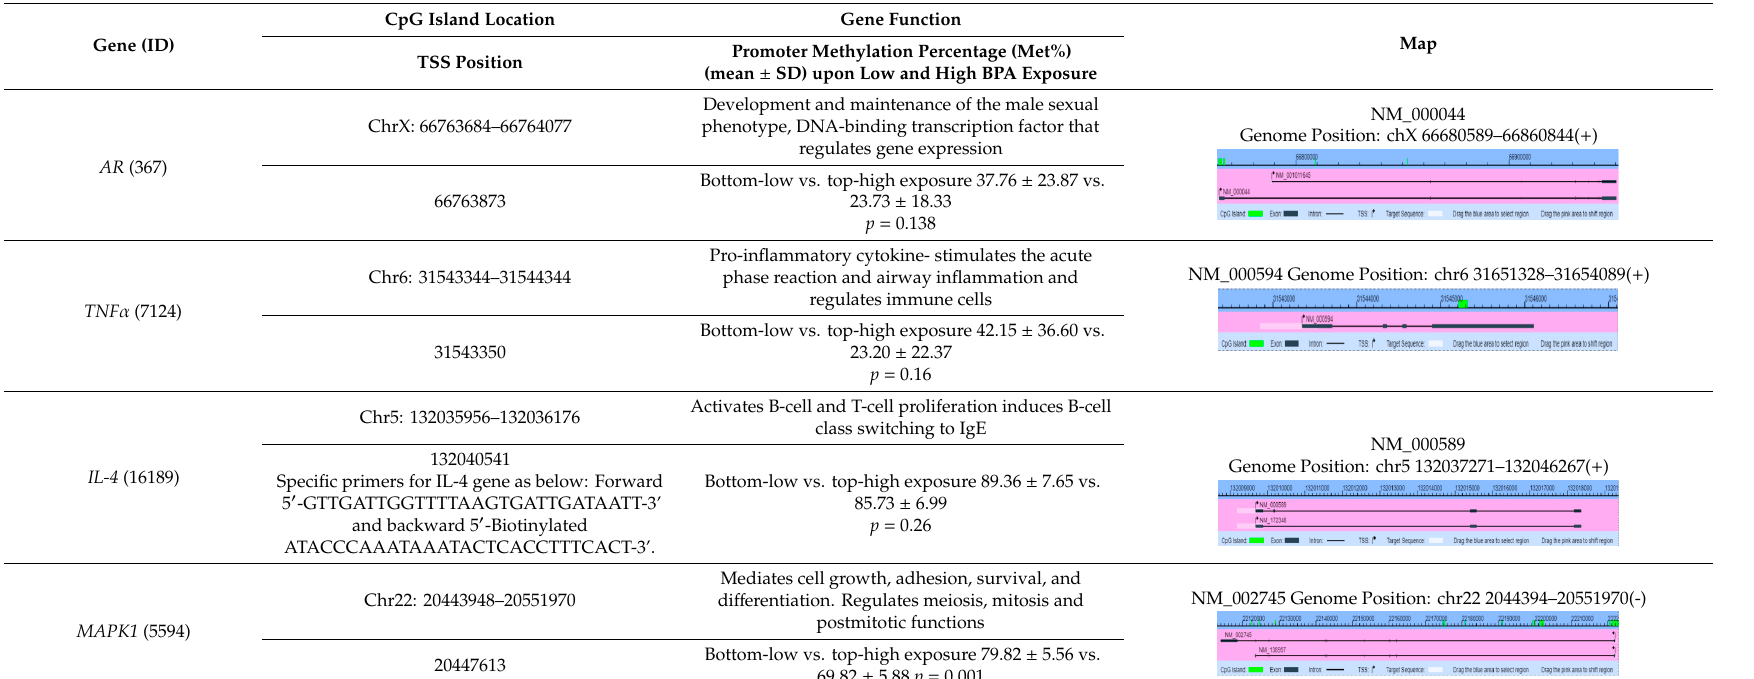
Figure source: MethPrimer 2.0.